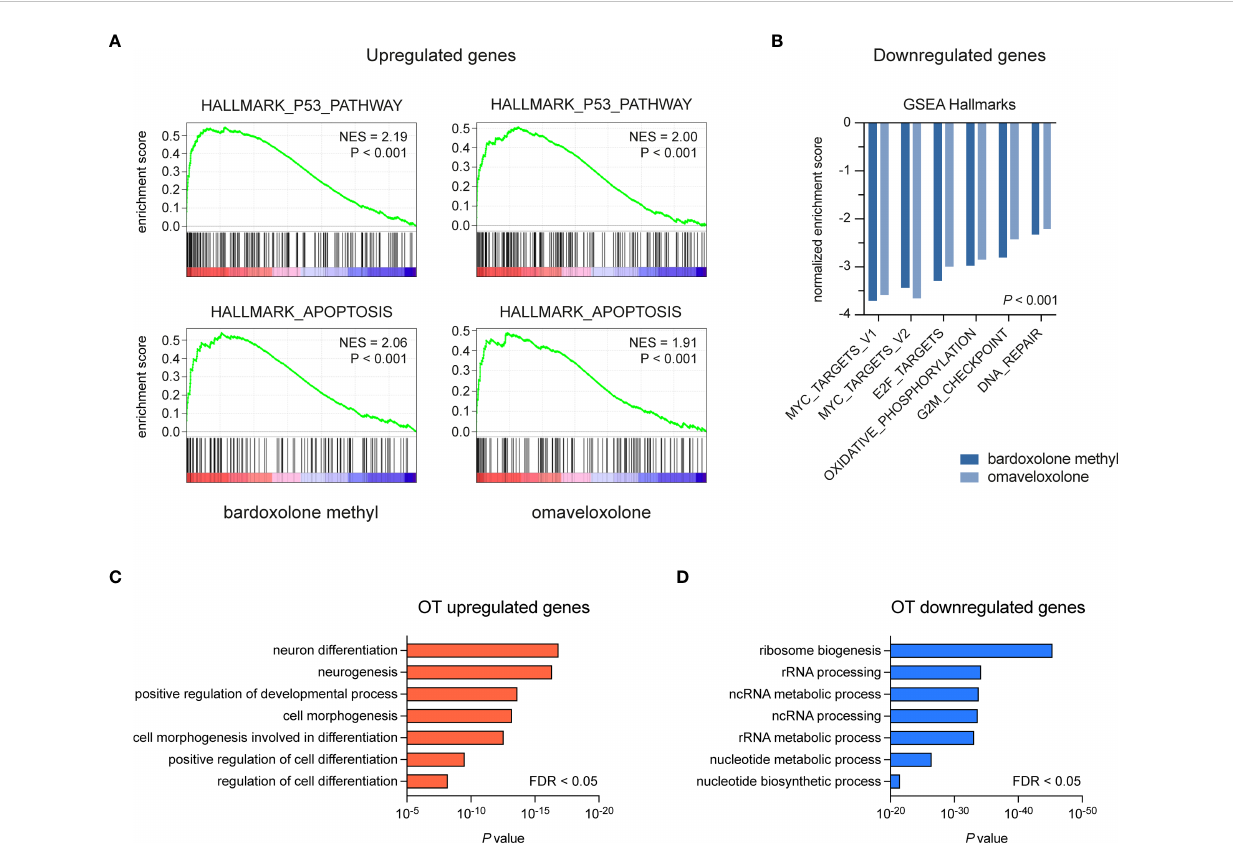
FIGURE 4 Gene set enrichment and gene ontology analysis of OT treated T-ALL cells. (A, B) Gene set enrichment analysis of pathways and gene sets affected by OT treatment in MOLT-4 cells. (C, D) Gene ontology analysis of up- and downregulated genes following OT treatment. NES, normalized enrichment score. FDR, false-discovery rate.